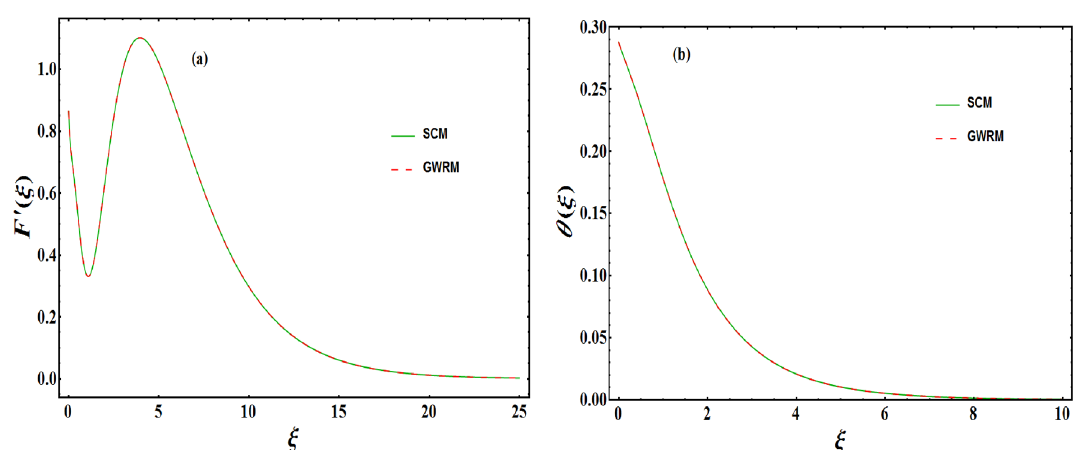
Figure 4. Comparison of the velocity and temperature profiles attained via SCM and